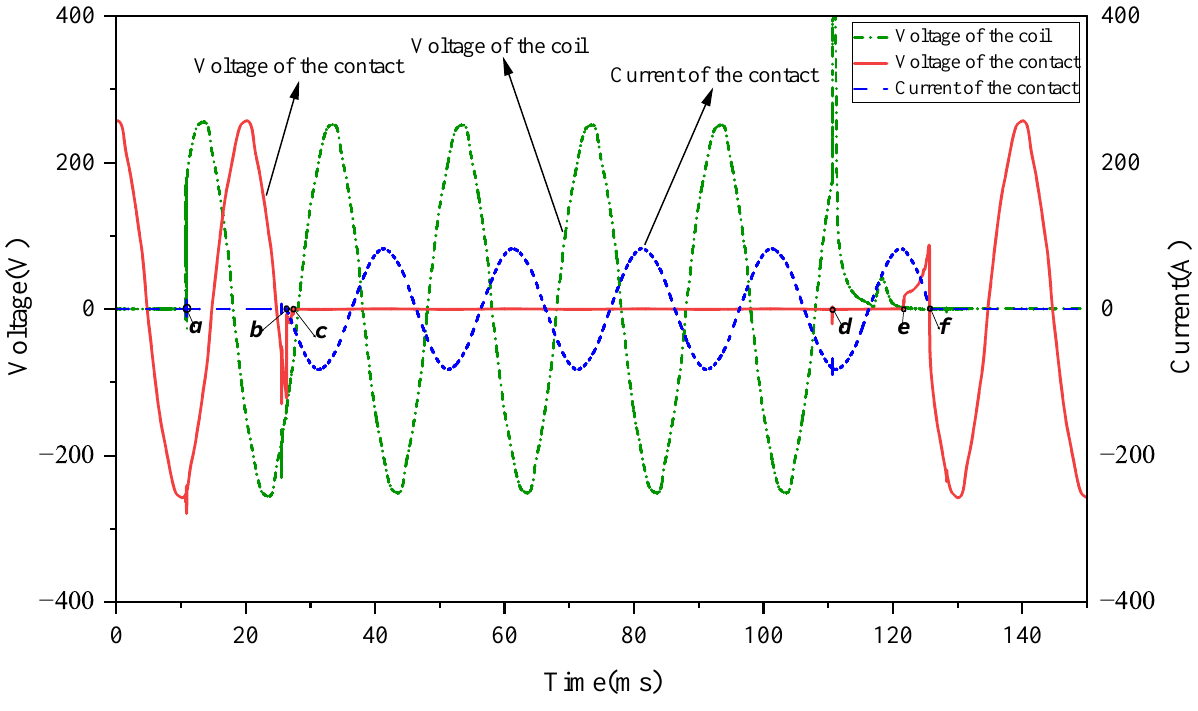
Figure 12. The normal breaking and closing waveform.